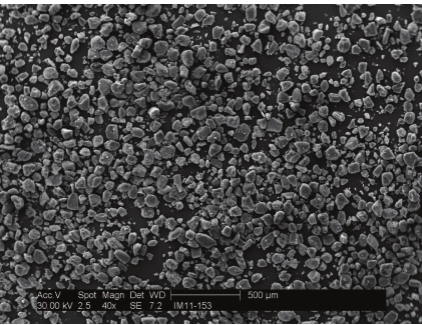
Figure 9: SEM image of pulverized cross-linked silica aerogels showing nonuniform geometries created by using the step-pulse pulverizing